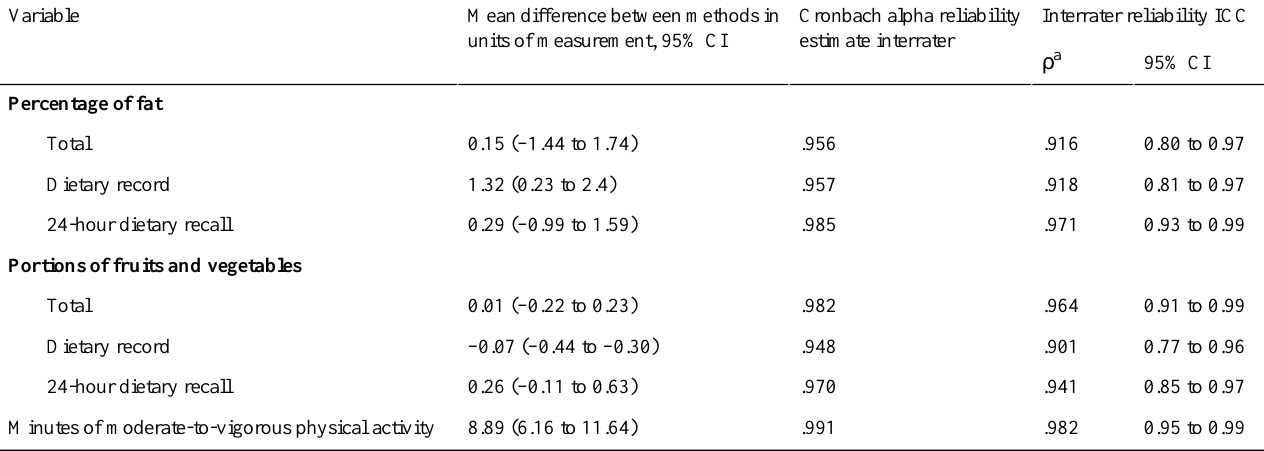
Table 1. Cronbach alpha reliability estimates and interrater reliability between the gold standard measurement and the Energy Balance on Cancer (BENECA) mHealth system. ICC: intraclass correlation